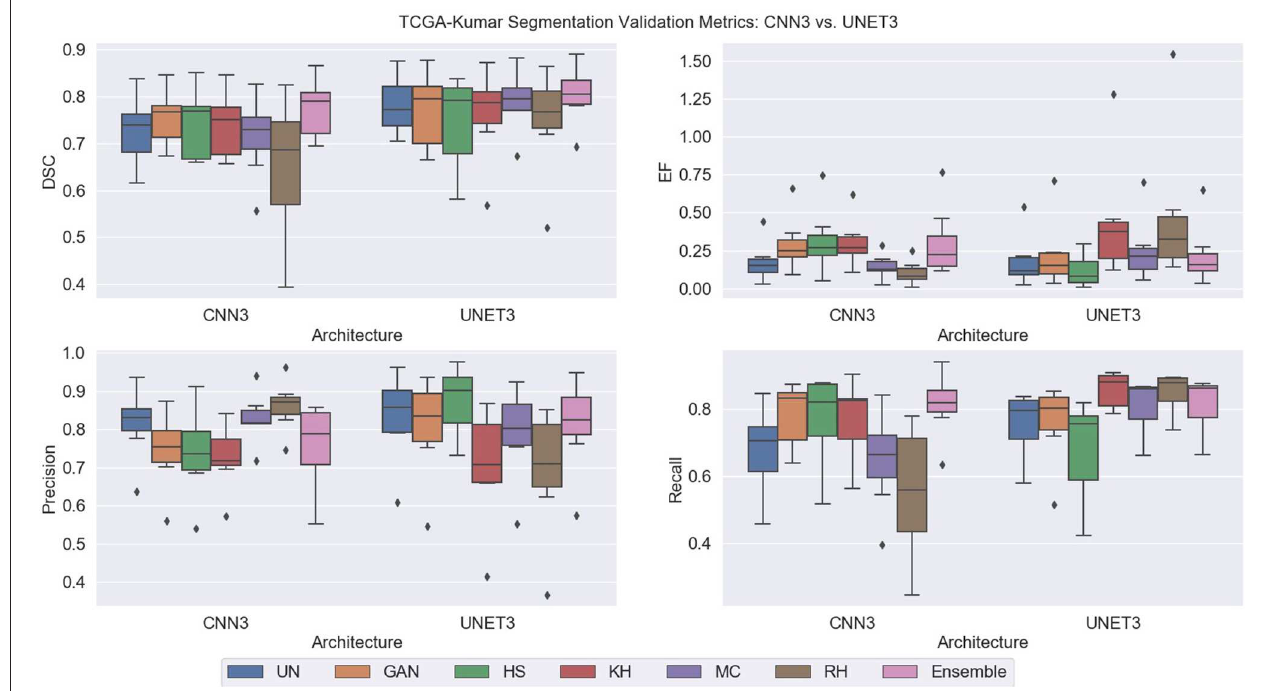
FIGURE 9 | TCGA-Kumar segmentation validation